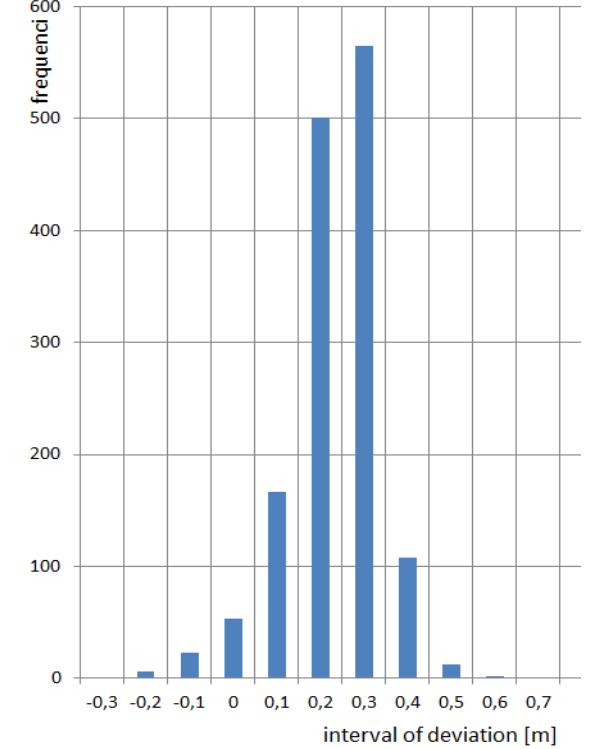
Figure 5. Histogram deviations of DMR 5 in the Dědice area (points on micro-relief objects excluded)